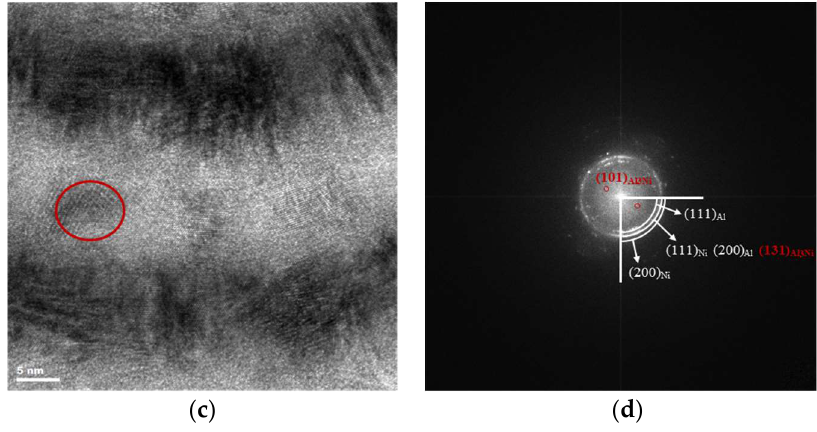
Figure 6. ( a , c ) High-resolution TEM (HRTEM) images; and ( b , d ) respective fast Fourier transform (FFT) in two regions of the Al / Ni (V) film with Λ = 25 nm ( V S = − 40 V, ion gun o ff ).